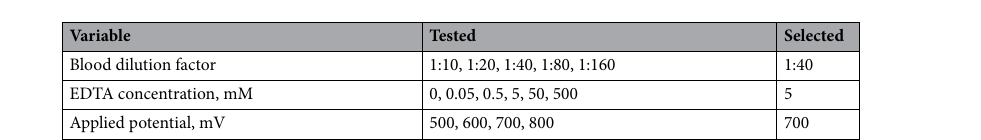
Table 2. Optimization of the experimental variables affecting the performance of the NADH electrocatalytic sensor using mouse blood.